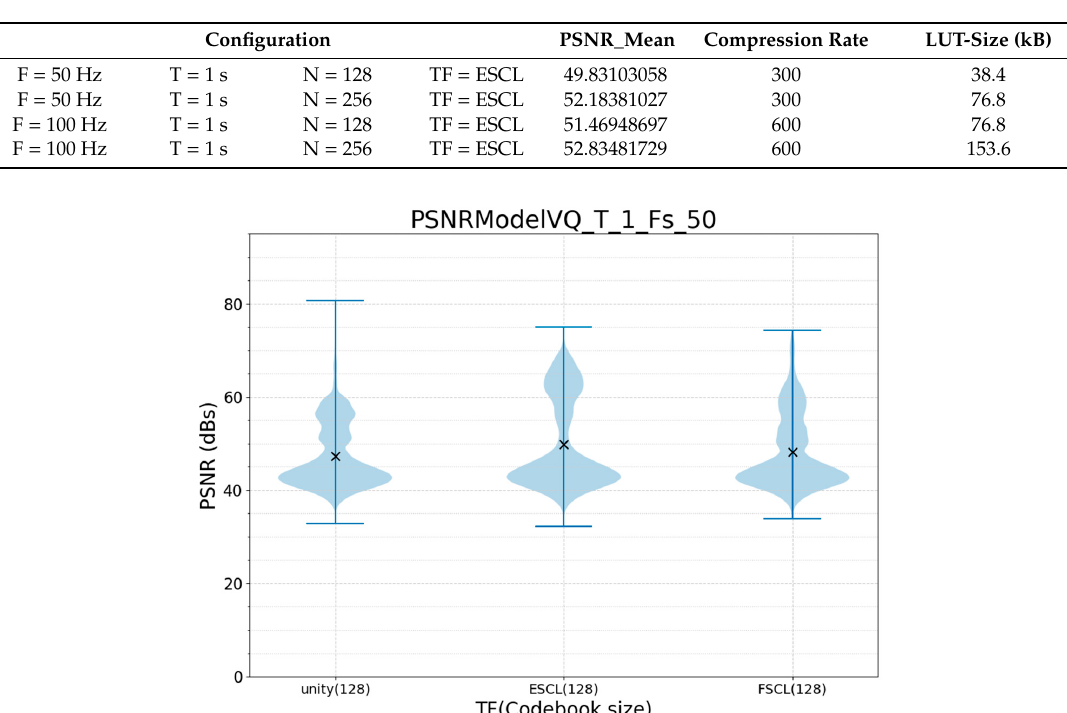
Table 3. Results for the embedded codification.